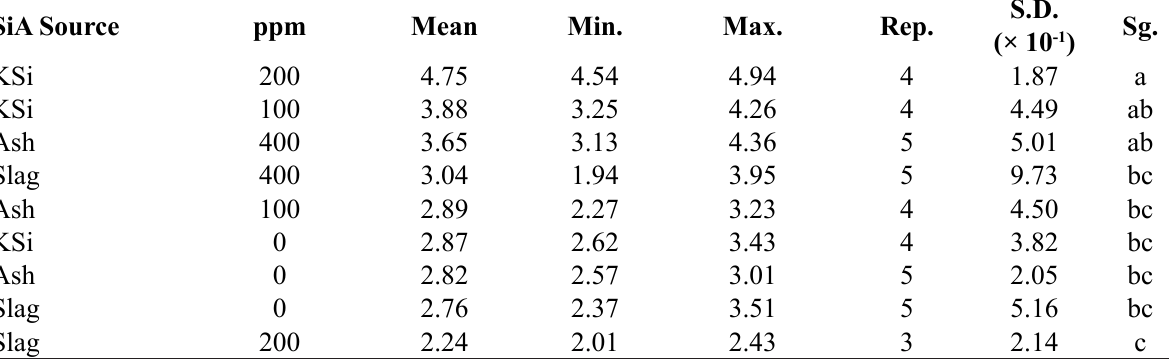
Table 8. Statistical summary of silicon concentration (%) in aerial organs. Significance levels were obtained with Tukey test, α =